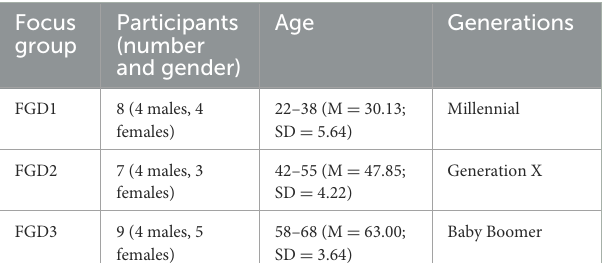
TABLE 1 Details of online focus group